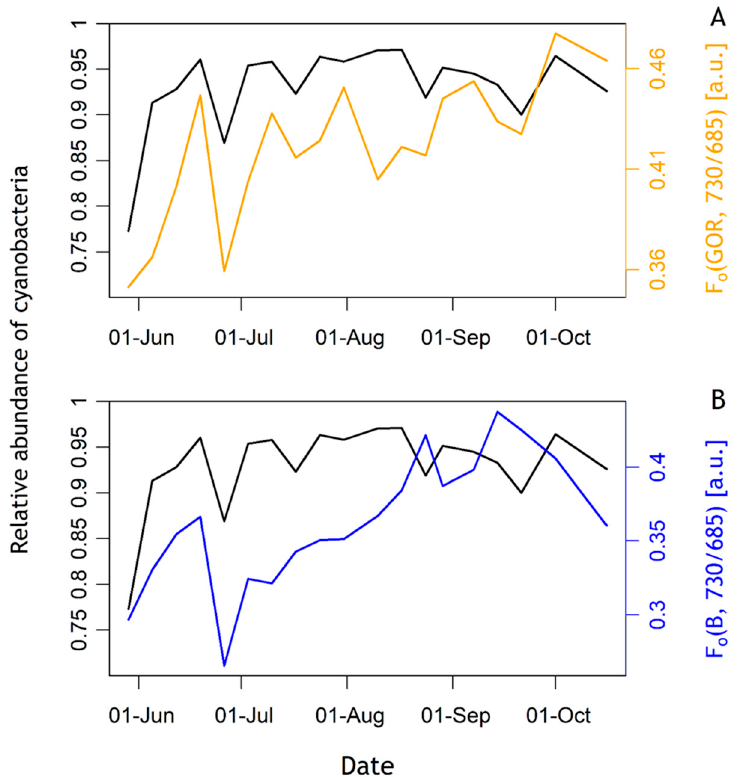
Figure 8. F o emission ratio using B and GOR excitation protocols compared to the relative abundance of cyanobacteria (black drawn line). ( A ) F o (GOR, 730/685) [a.u.], ( B ) F o (B, 730/685) [a.u.].